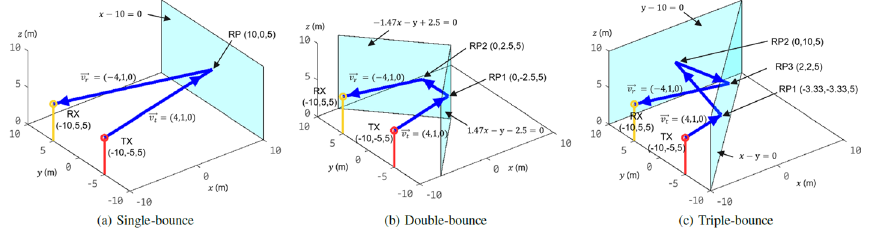
Fig. 1 Trajectories of a radio ray between TX and RX with different numbers of